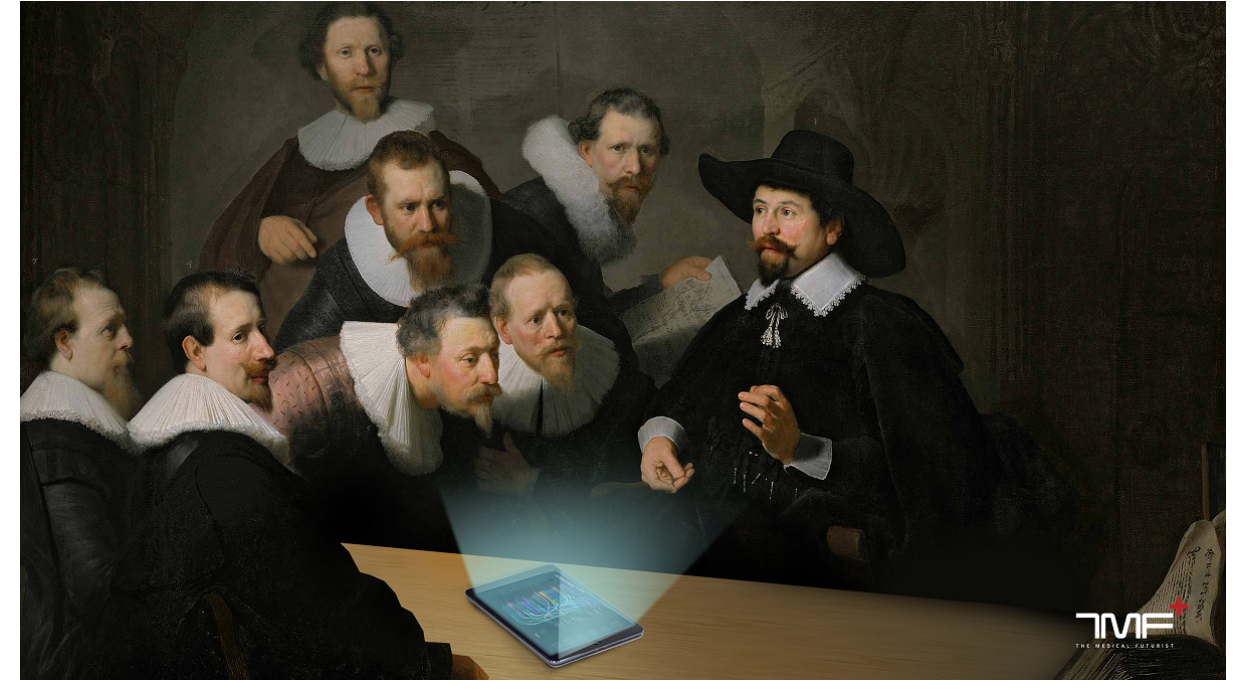
Figure 1. A concept art about the art of medicine in the era of artificial intelligence based on Rembrandt's painting The Anatomy Lesson of Dr Nicolaes